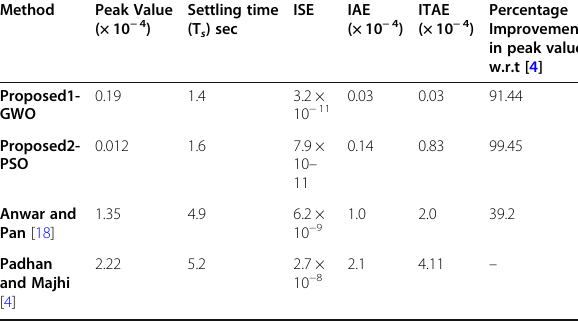
Table 2 Comparison analysis for case study 2